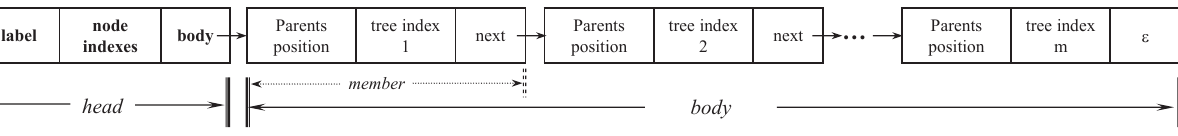
Figure 4. Structure of a label